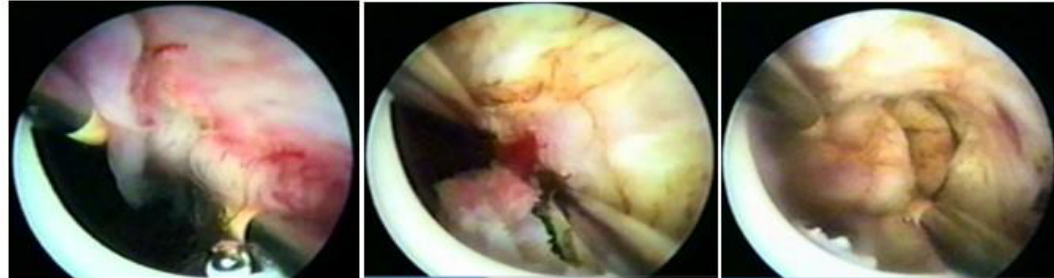
Figure 10. Slicing